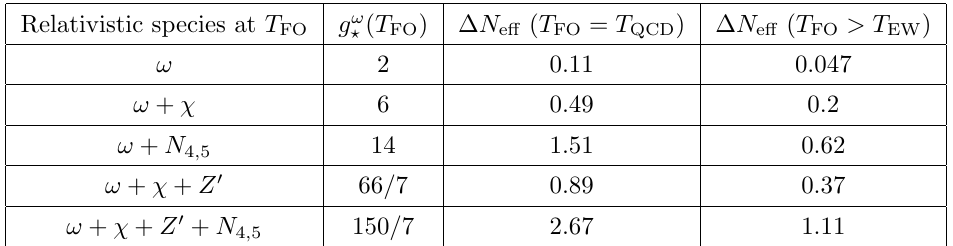
Table 2 . E(cid:11)ective relativistic fermionic degrees of freedom of the dark sector for a given speci(cid:12)c particle content at T FO and corresponding contributions to (cid:1) N e(cid:11) , assuming the freeze-out to occur at the QCD phase transition T FO = T QCD and above the electroweak phase transition T FO > T EW